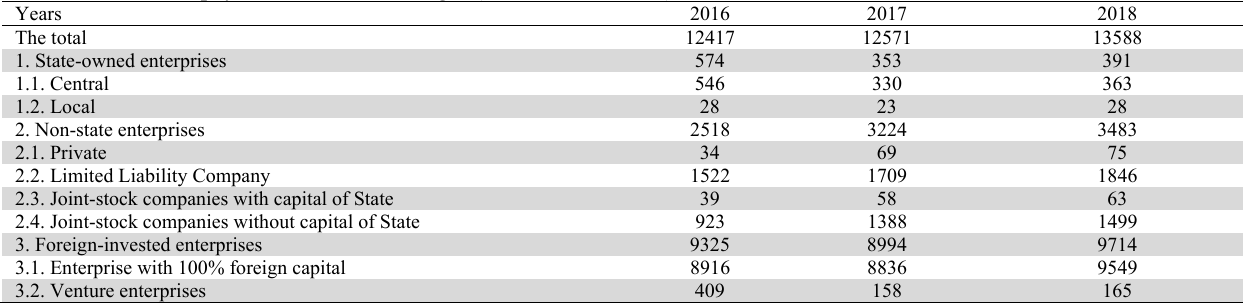
Taxes and amounts payable to the state budget (Unit: VND billion) Years